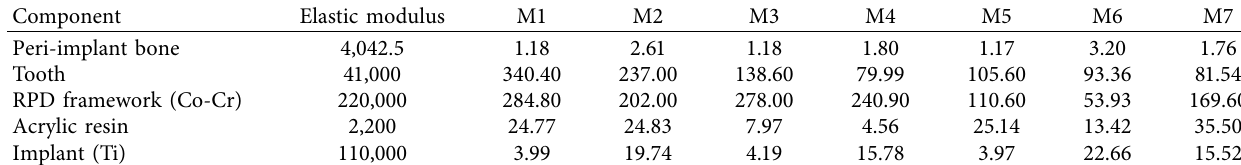
Table 5: Maximum von Mises stress compared to the elastic modulus of the materials